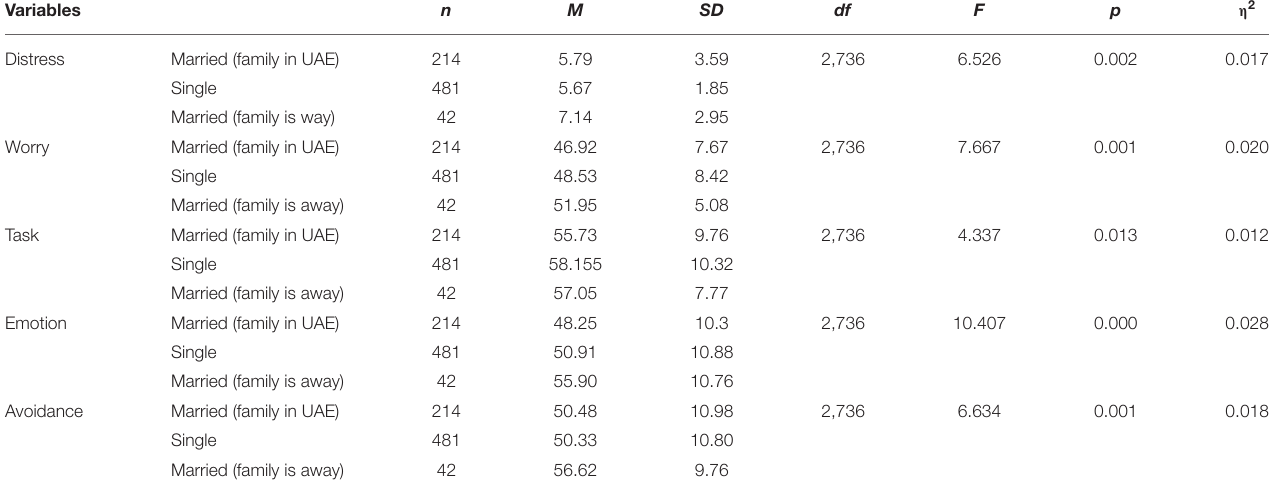
TABLE 6 | ANOVA results of differences in distress, worry, and coping across marital status. Variables